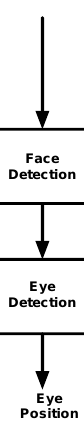
Figure 2. Used eye tracking algorithm